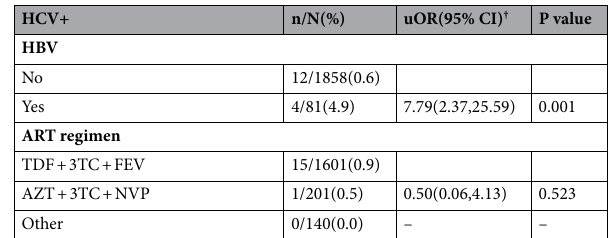
Table 2. Bivariable associations between sociodemographic, clinical and facility characteristics of the study population. * The analytical sample was derived from the enrollment data of an ongoing cluster randomized controlled trial, aimed at evaluating the effect of data-driven continuous quality improvement on long-term ART outcomes in Kinshasa, Democratic Republic of Congo. We retained participants that had available data on HCV rapid testing. SES, socio-economic status; RNA, ribonucleic acid; ART, antiretroviral therapy; HBV, hepatitis B virus; uOR, unadjusted odds ratio; aOR, adjusted odds ratio; 95%CI, 95% confidence interval. § Facility at which participant was enrolled/tested. ¶ Calculated using principal component analysis and categorized in three groups: the lower first two quintiles, the middle quintiles, and the last two quintiles. #Self-report of emotional or physical or sexual partner violence. **Self-report of disclosure of HIV status to anyone. † OR and 95%CI were obtained using logistic models and generalized estimating equation to adjust for potential clustering at the level of the